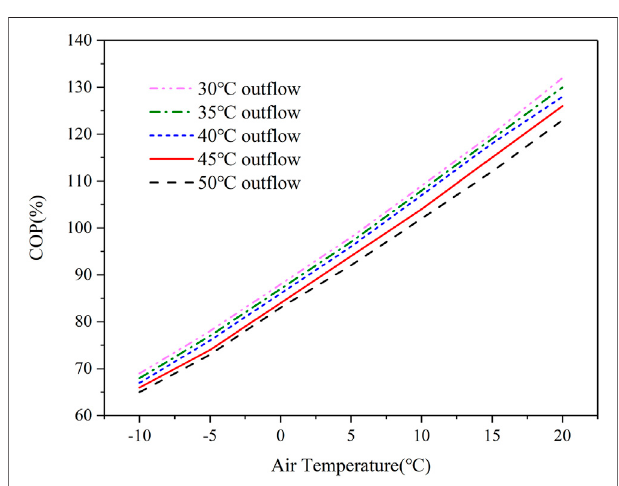
FIGURE 14 | Heating performance coef fi cient correction curve (manufacturer).